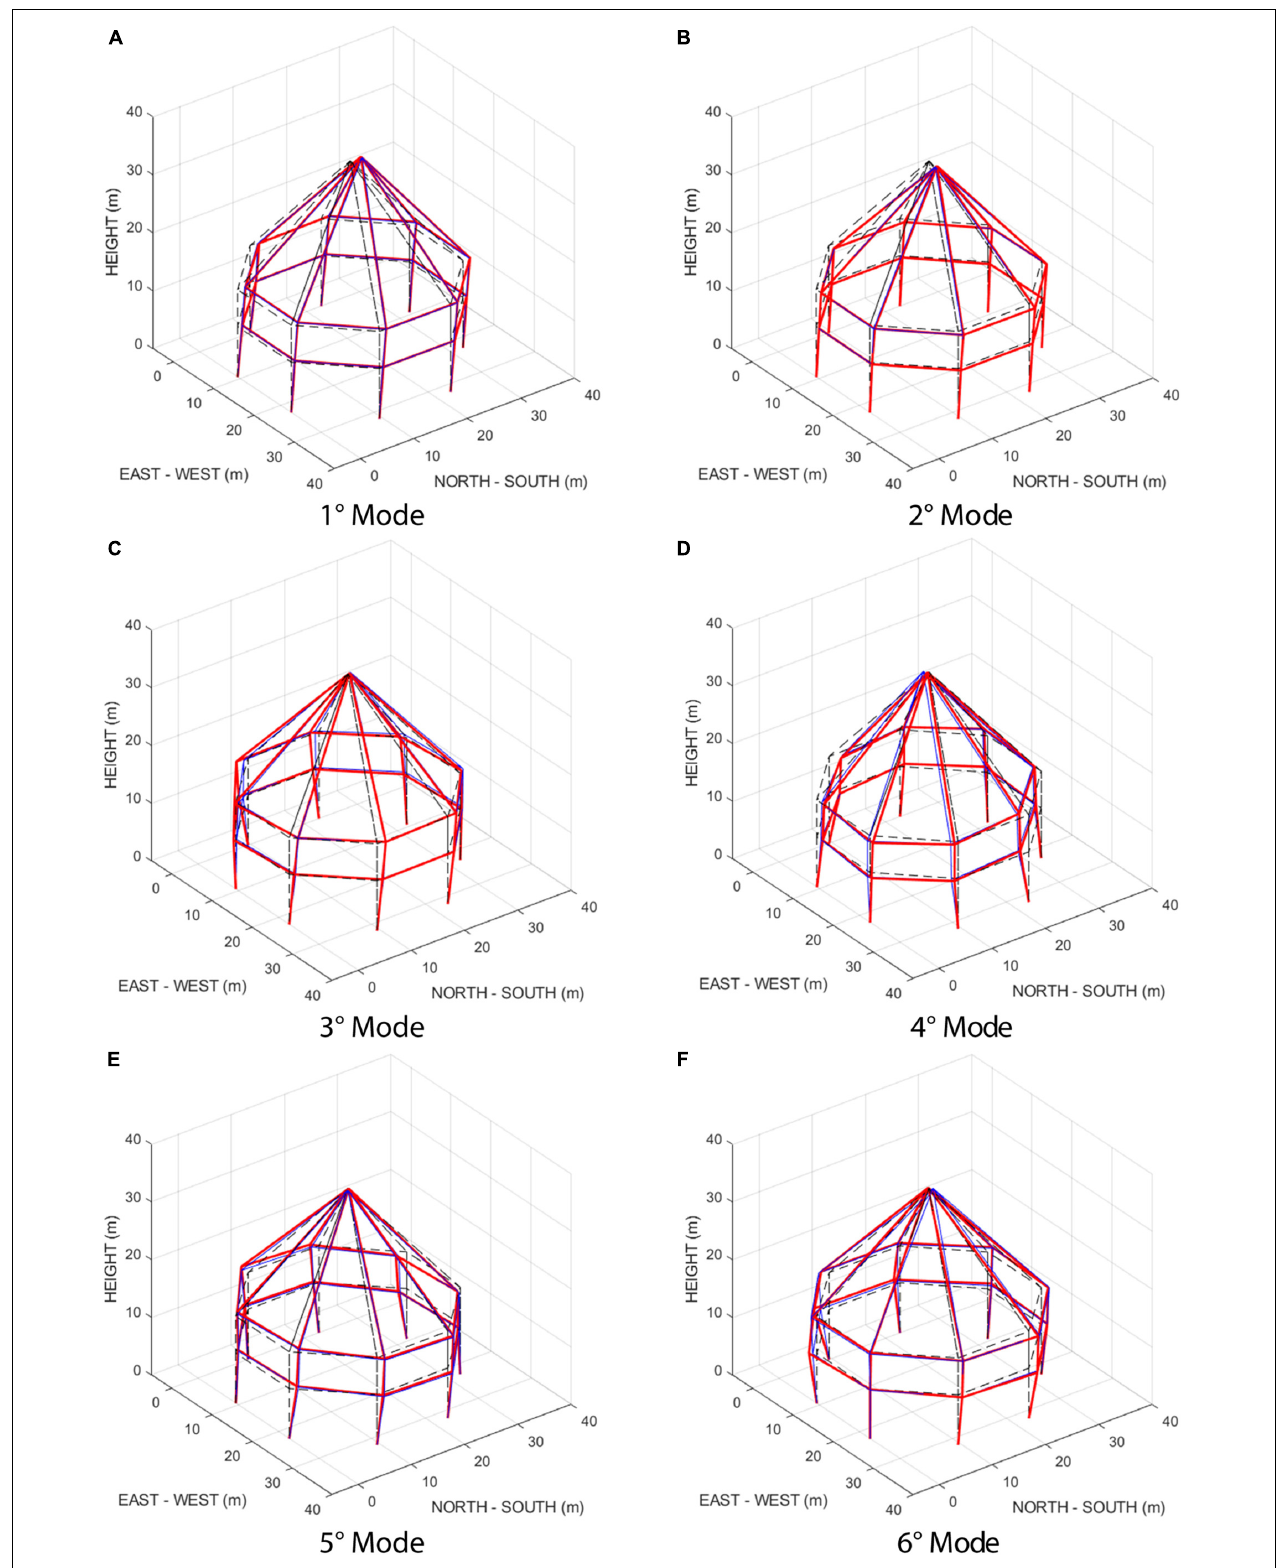
FIGURE 4 | (A) 1 ◦ Mode, (B ) 2 ◦ Mode, (C) 3 ◦ Mode, (D) 4 ◦ Mode, (E) 5 ◦ Mode, and (F) 6 ◦ Mode. Three-dimensional representation of the identified 6 mode shapes (blue lines) and of the numerical mode shapes obtained with the identified FE model (red lines).